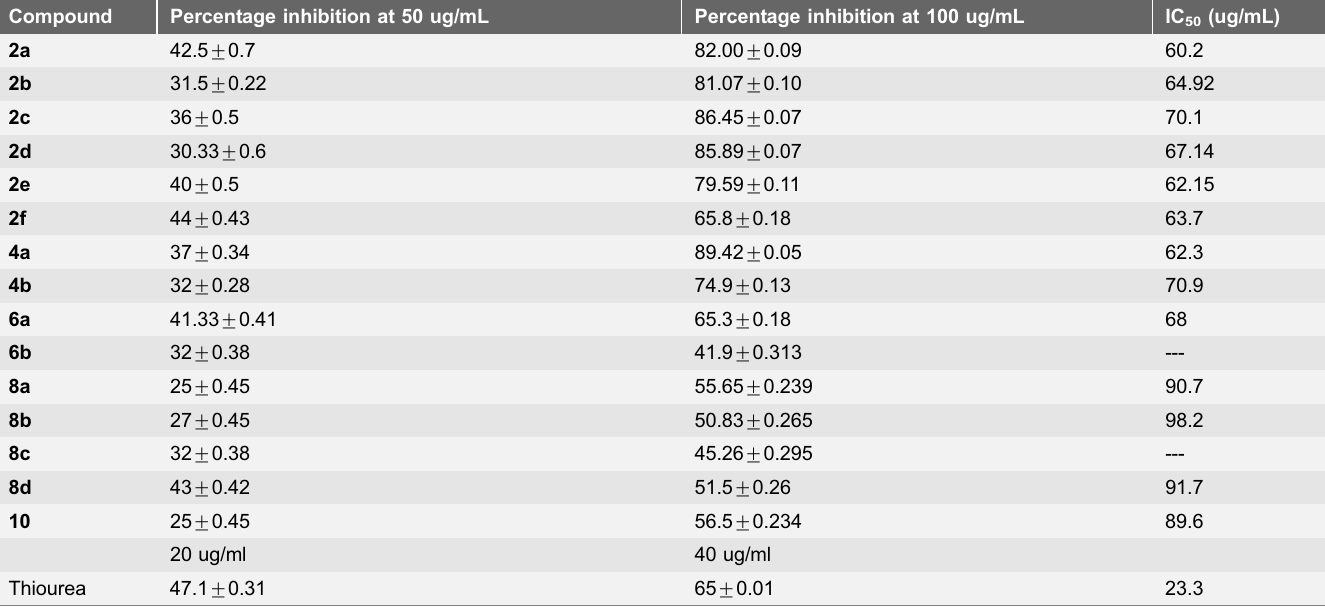
Table 6. Urease inhibition studies of